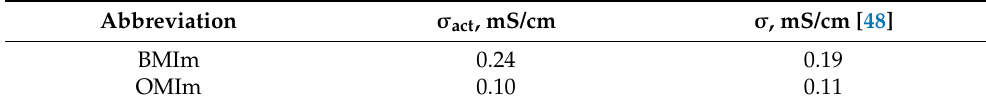
Table 6. Ionic conductivity of the membranes.